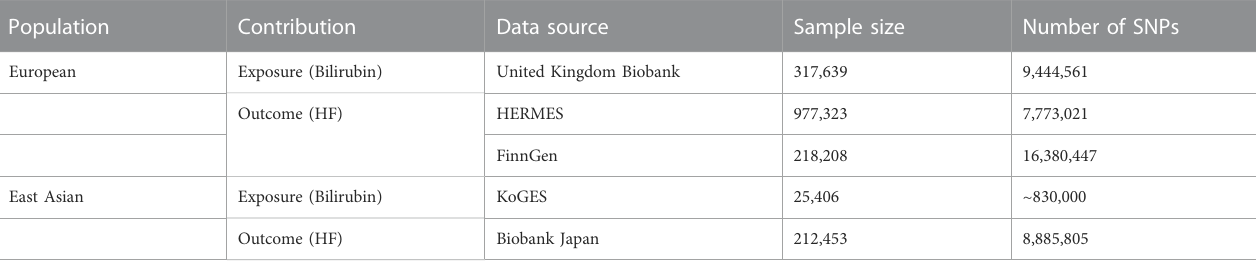
TABLE 1 Detailed information for studies and datasets used for MR